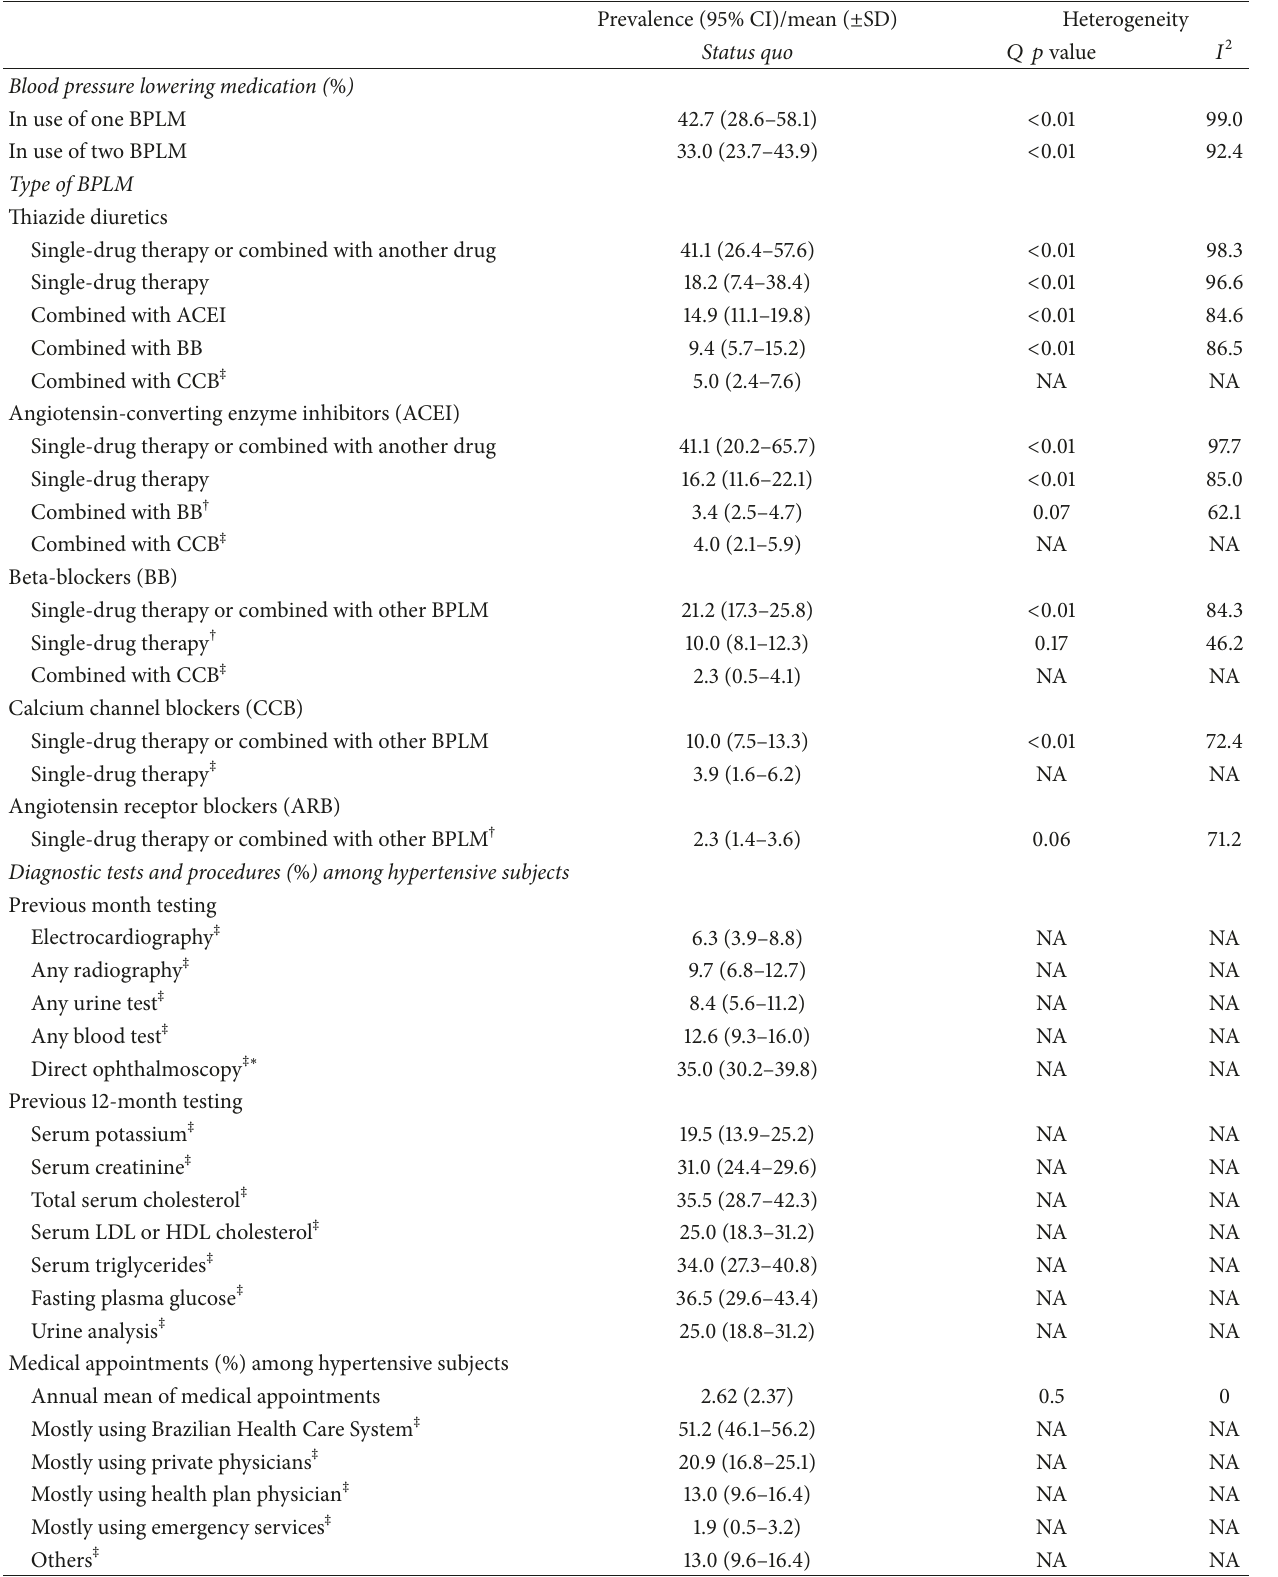
Table 2: Frequency of blood pressure lowering medication use, diagnostic tests, and medical appointments among hypertensive